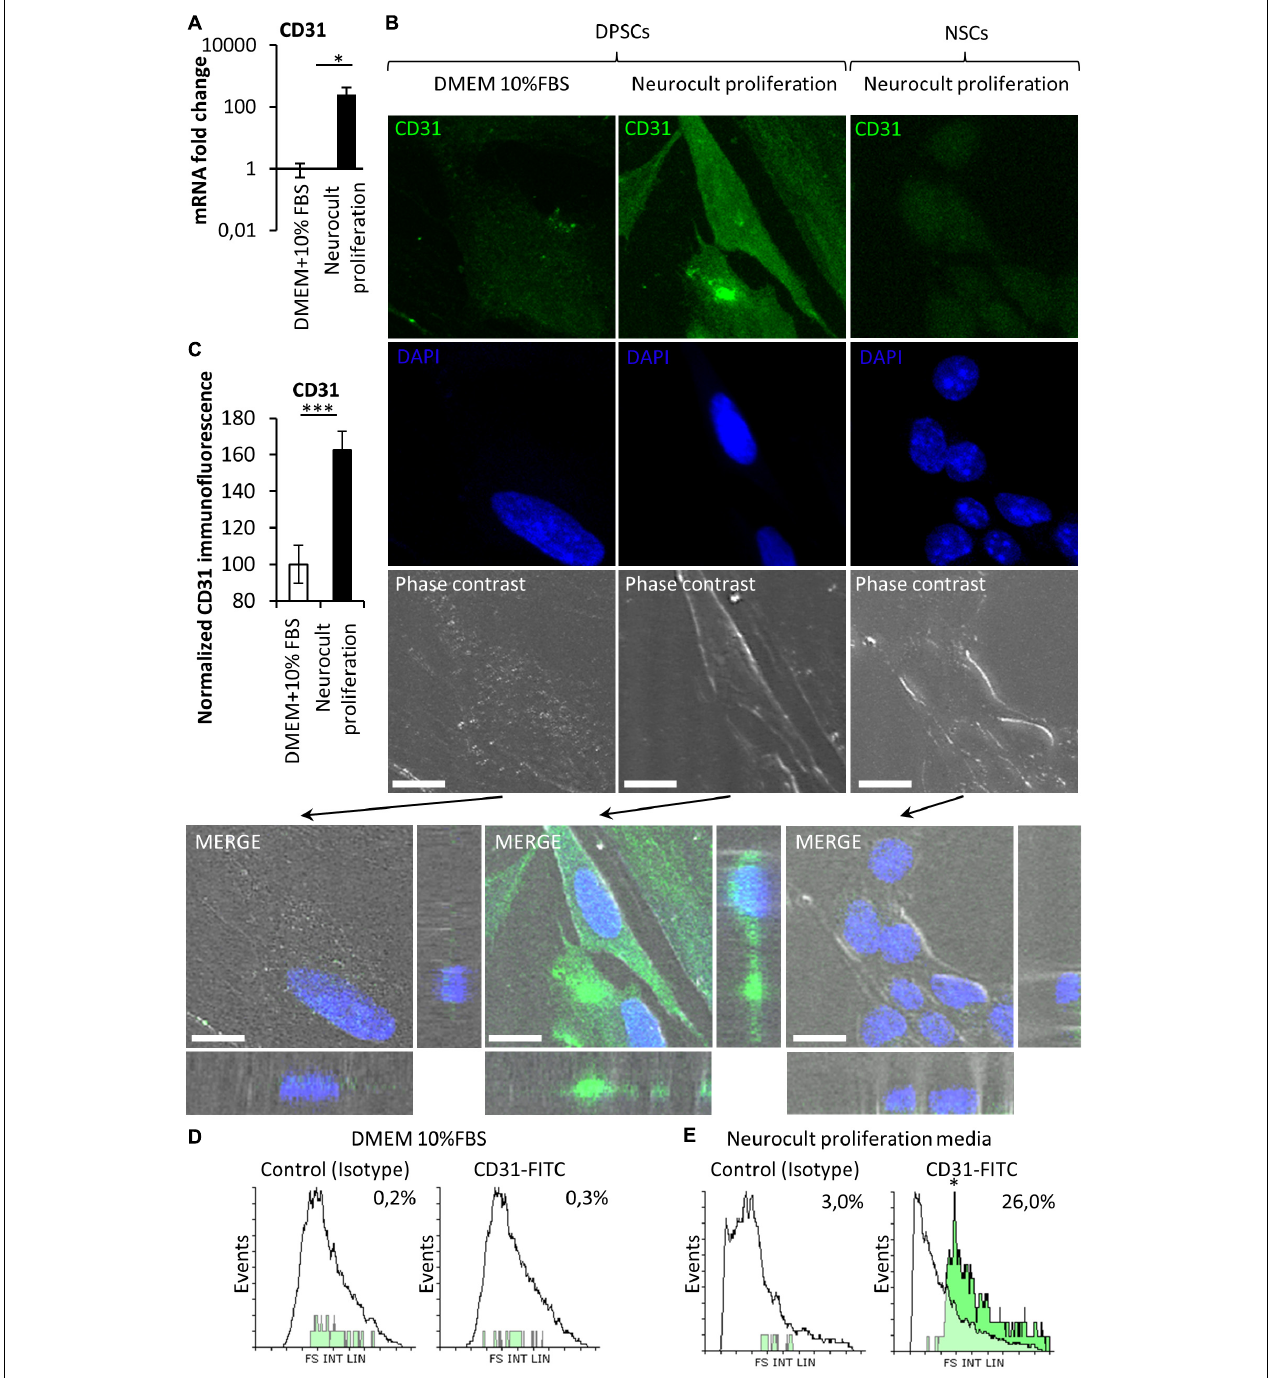
FIGURE 3 | The endothelial marker CD31 is absent from NSCs whereas it can be enriched depending on the type of culture medium in DPSCs. (A) mRNA fold change of the endothelial marker CD31 on DPSC cultures depending on the culture medium: DMEM/FBS vs. Neurocult proliferation. Axis represented as logarithmic scale of CD31 expression from DPSC cultures of four different patients (mean ± SEM ∗ p = 0.05, one-tailed Mann–Whitney test). (B) CD31 immunofluorescence and orthogonal projection of DPSCs cultured with ( left column ) DMEM + 10% FBS or ( middle column) Neurocult proliferation media NSC ( right column ) cultured with Neurocult proliferation. Scale bars 10 µ m. (C) Quantification of the immunolabeling signal intensity for CD31 (mean ± SEM of two independent experiments, n = 10 for DMEM 10% FBS and n = 10 for Neurocult proliferation, ∗∗∗ p = 0.0008, one-tailed Mann–Whitney test), and (D) flow cytometry analysis for CD31 expression in DPSC culture with DMEM + 10%FBS or (E) Neurocult proliferation media ( n = 10.000 events for each condition; ∗ p = 0.05, one-tailed Mann–Whitney test).